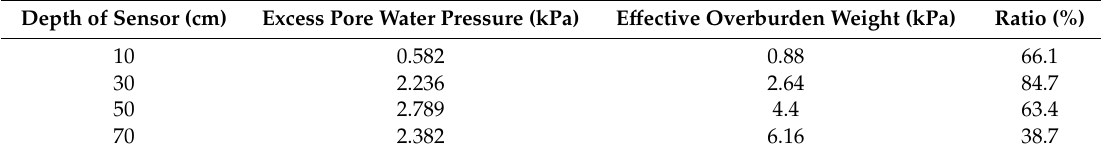
Table 5. Ratio of excess pore water pressure to e ff ective overlying soil weight at di ff erent depths. Depth of Sensor (cm)